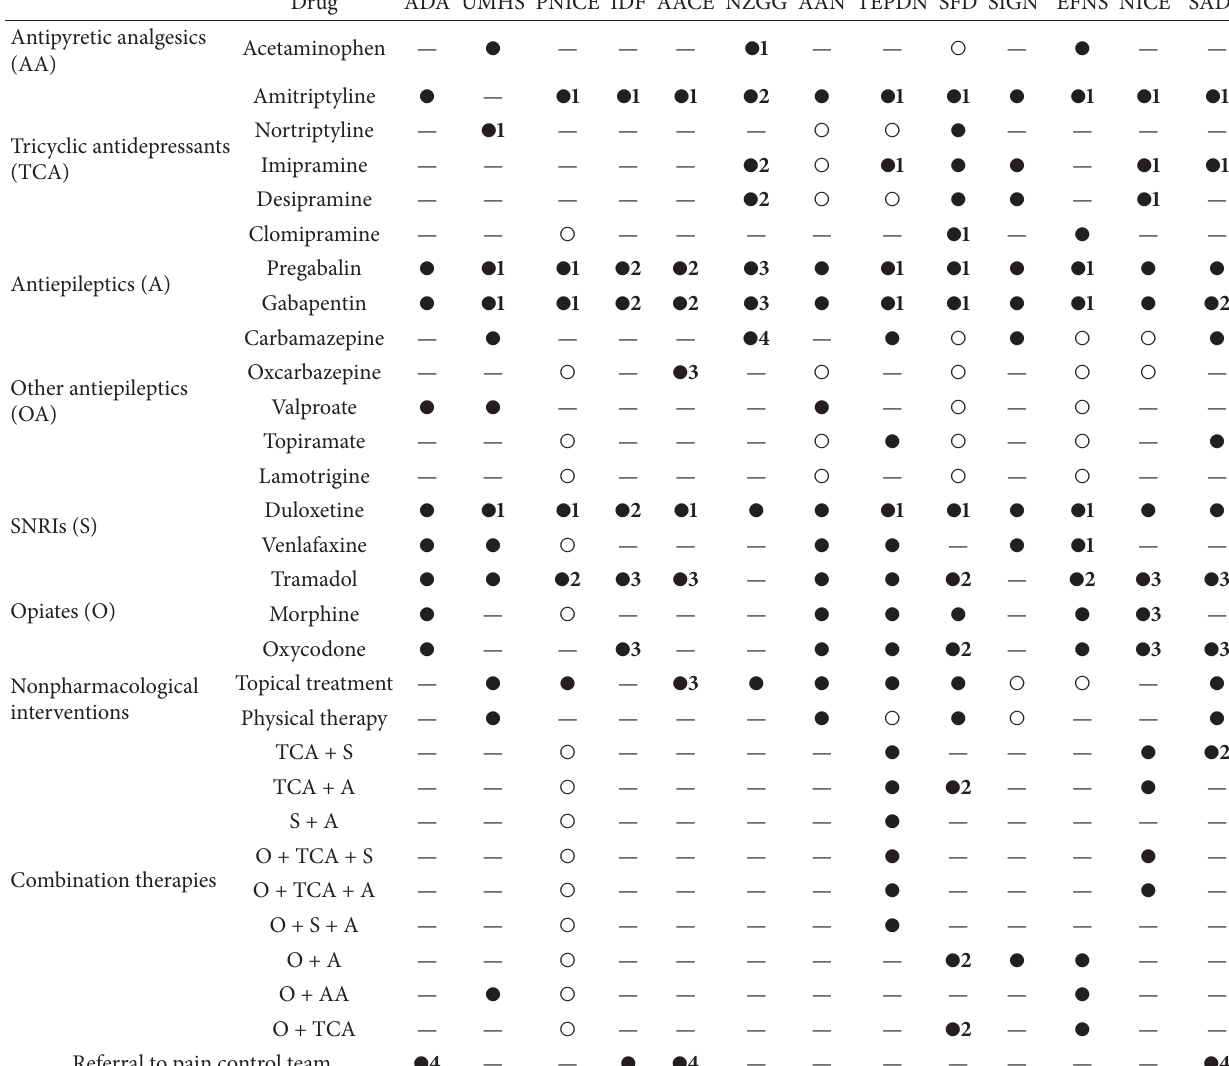
Table 3: Recommendations regarding symptom management for painful